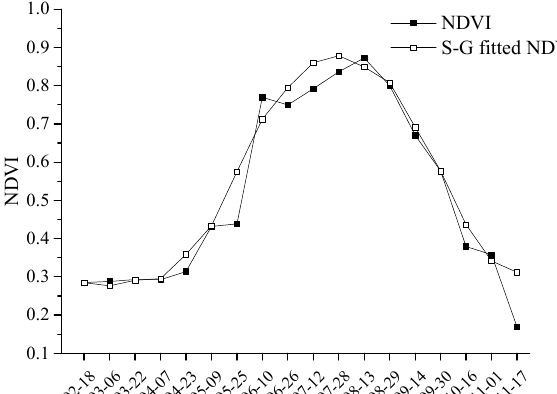
Figure 5. Comparison of the NDVI profiles before and after Savitzky-Golay (S-G) filtering. x -axis refers to the dates of the synthetic images.